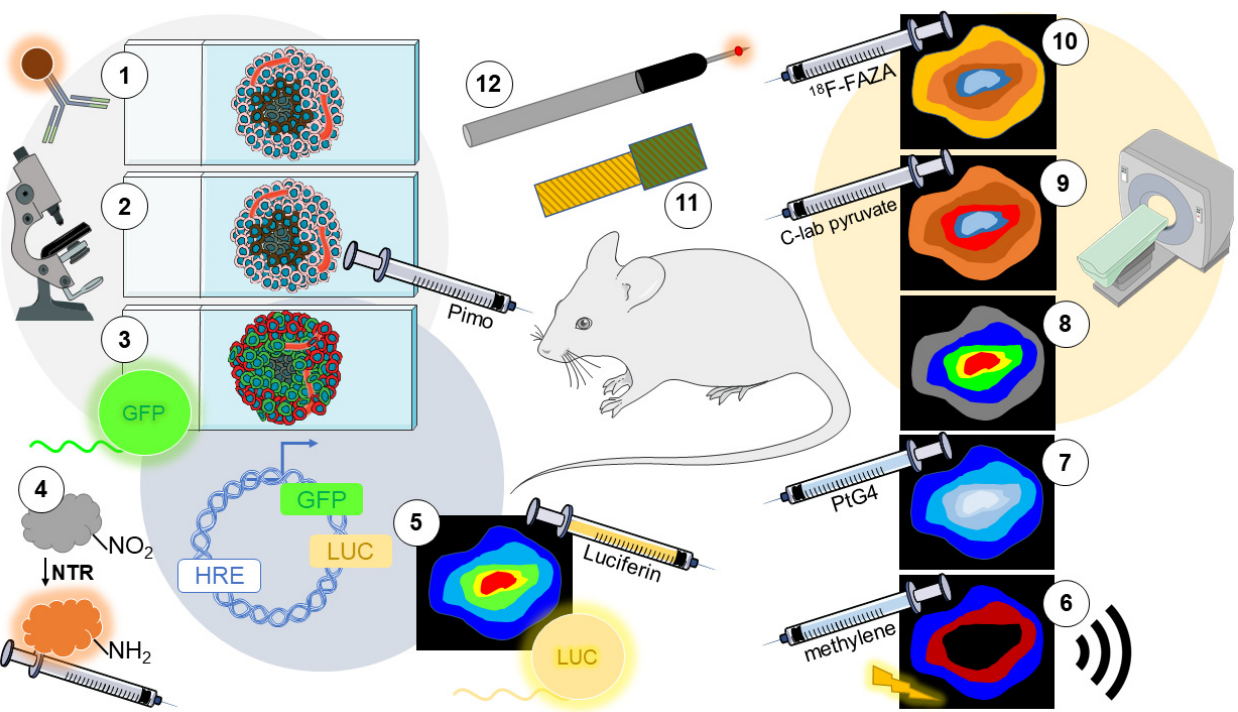
Figure 2. The detection of hypoxia in vivo. ( 1 ) Immunolabeling of endogenous hypoxia markers in tumor sections by IF/IHC. ( 2 ) Immunolabeling of exogenous hypoxia probes delivered via I.P./I.V. injection 1–2 h before sacrificing the animal (e.g., pimonidazole) in tumor sections by IF/IHC or FC